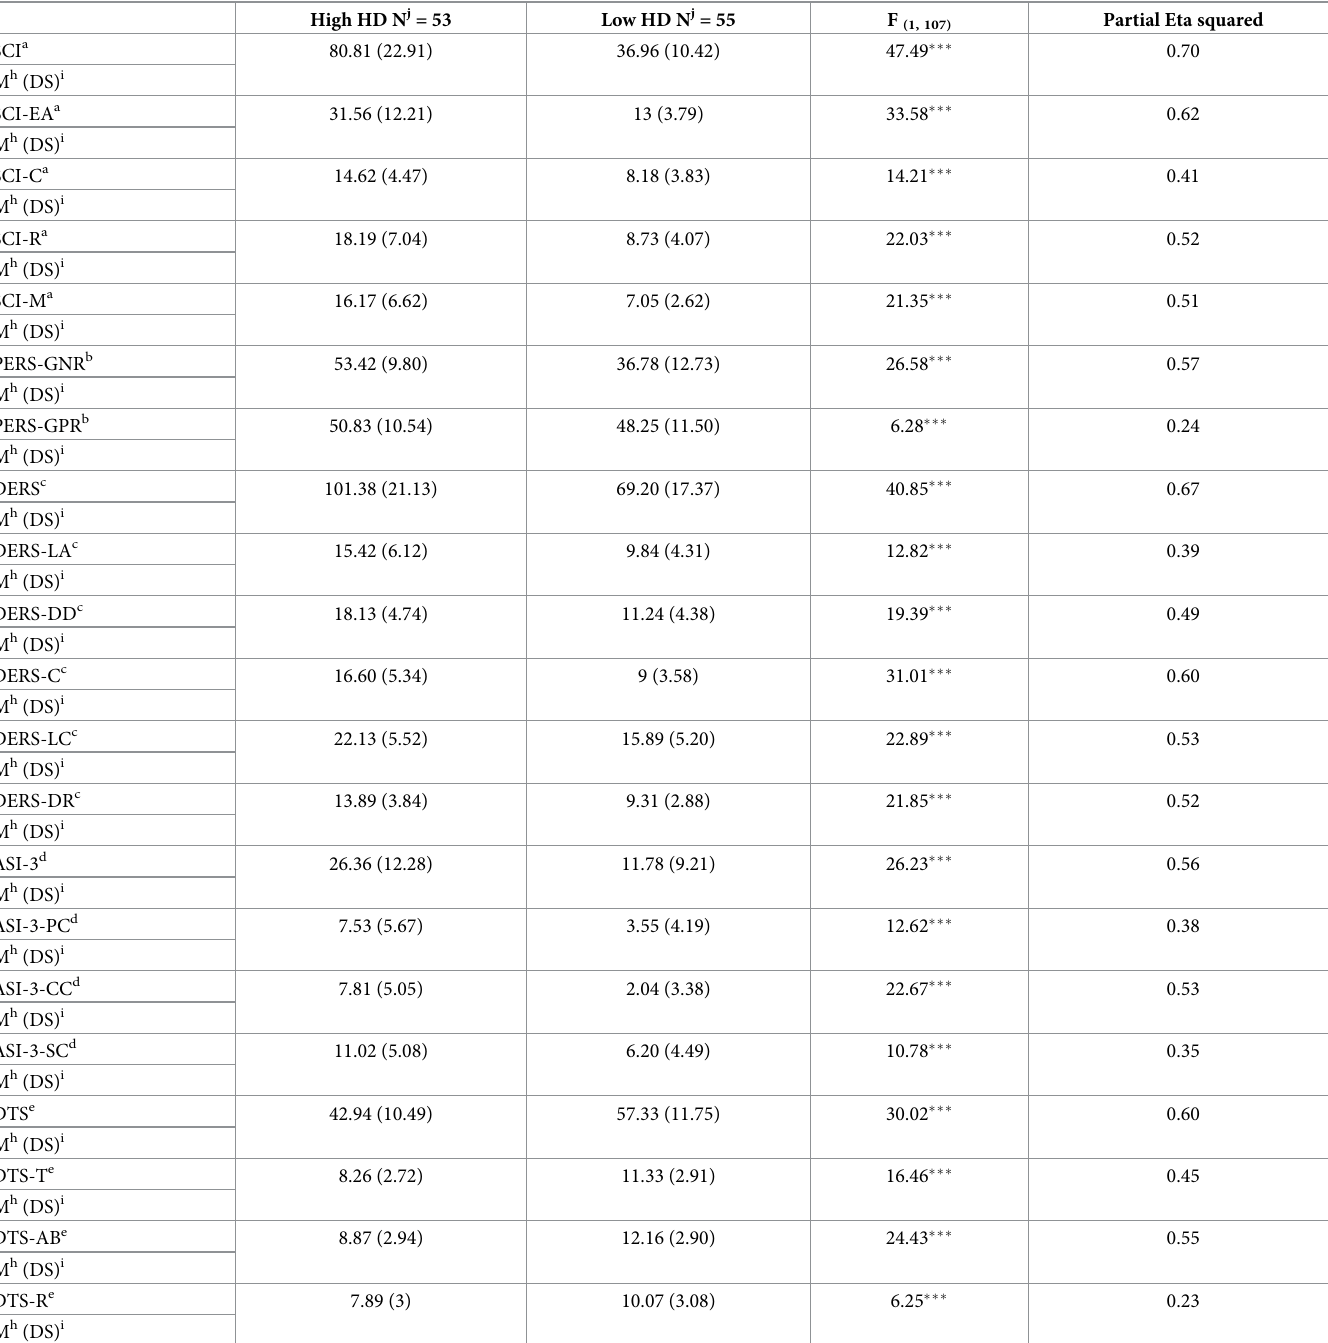
Table 2. Comparisons between the high and the low HD groups (controlling for the effect of gender, the BAI, BDI-II,